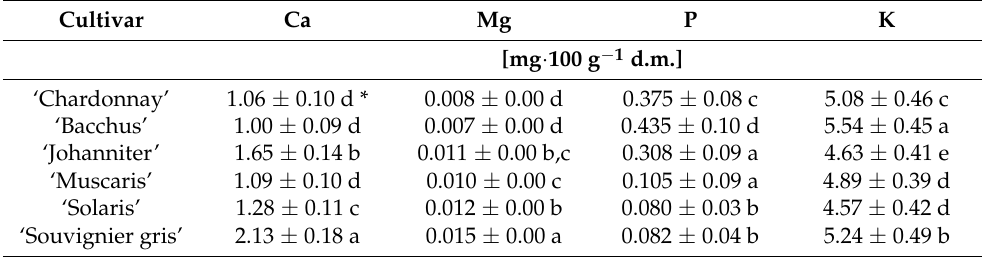
Table 4. Macronutrient content of six cultivars of white